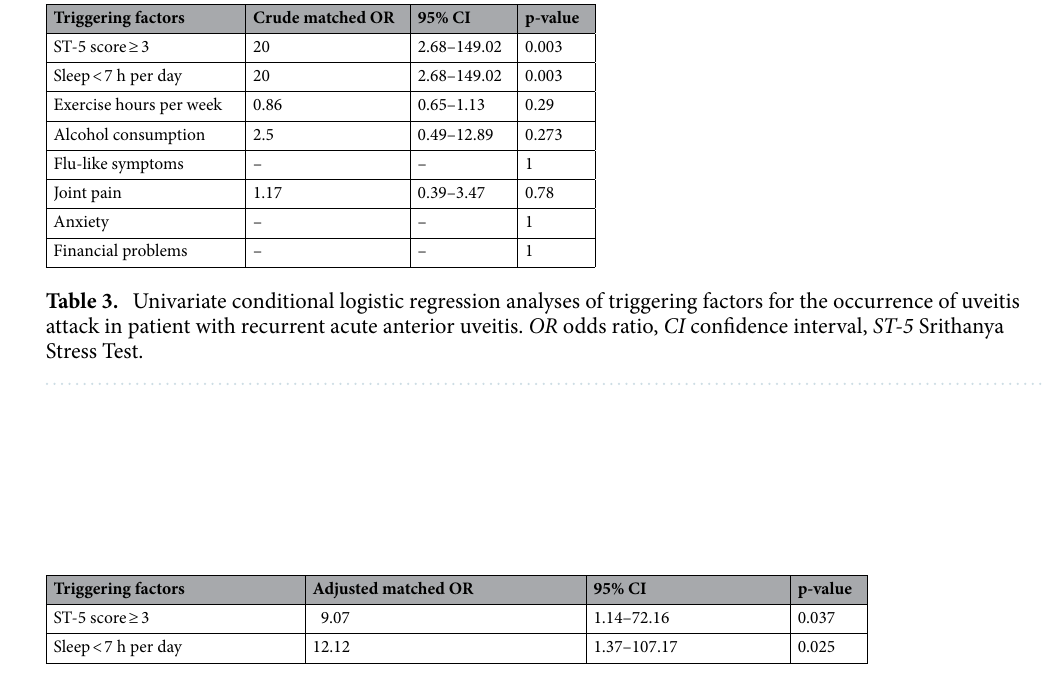
Table 4. Multivariable conditional logistic regression model of triggering factors associated with recent acute anterior uveitis attack adjusted for age, sex, HLA-B27 positivity, and concurrent systemic anti-inflammatory medications. OR odds ratio, CI confidence interval, ST-5 Srithanya Stress